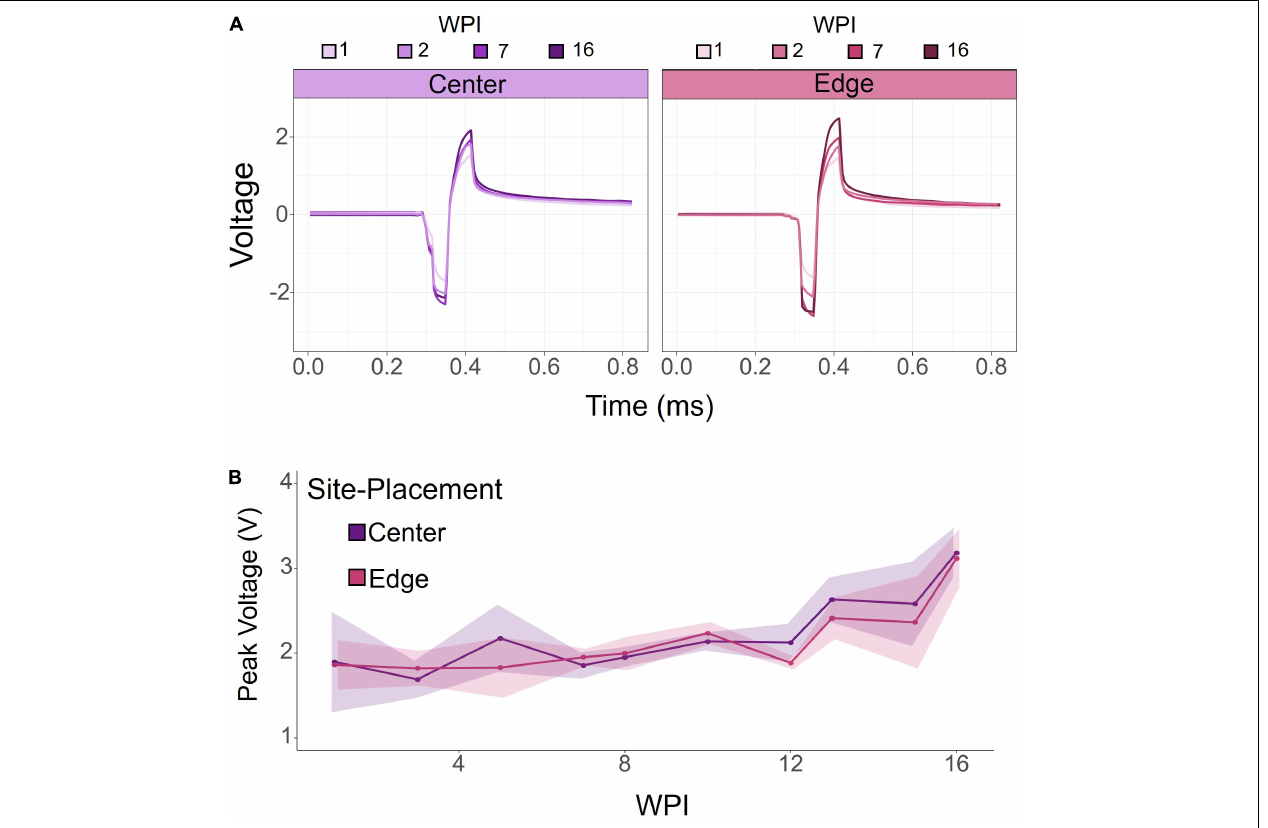
FIGURE 4 | Voltage transients of contiguous center and edge channels over time. (A) Representative voltage transients of center and edge electrode-sites at the same cortical depth. Both center and edge channels show an increasing voltage transient over time. (B) Peak voltage for center and edge channels from all animals. Peak voltage increased over time for both center and edge channels. There was no significant difference between center and edge peak voltages. Shading indicates standard